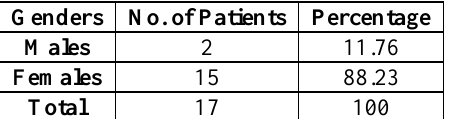
Table 1: Gender distribution statistics Genders